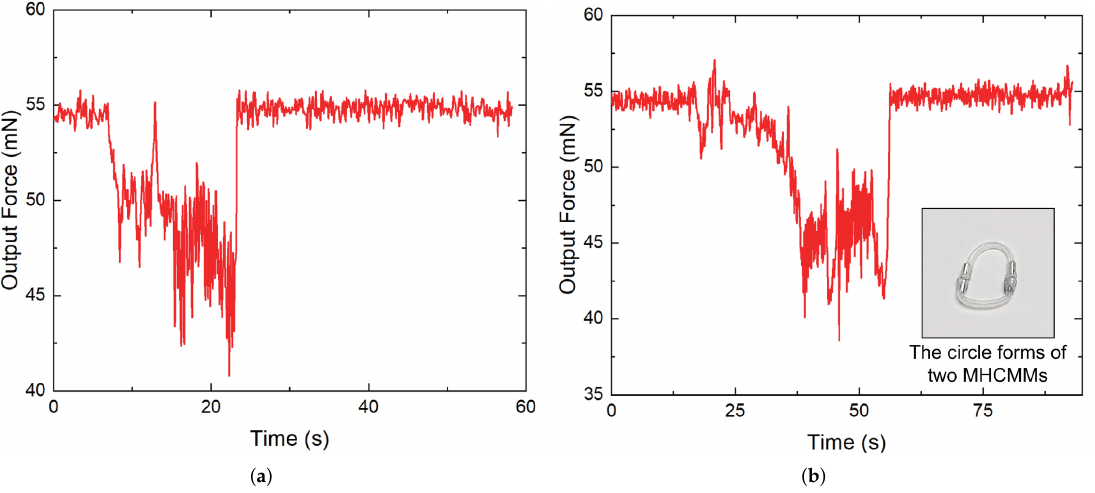
Figure 14. Microforce measurement result of circular MHCMM. ( a ) One ring is measured with the microforce measurement instrument for determining the tensile force, which can be released under constant magnetic field traction; ( b ) microforce measurement results with two MHCMMs, which provides an indication for the next step study of cluster